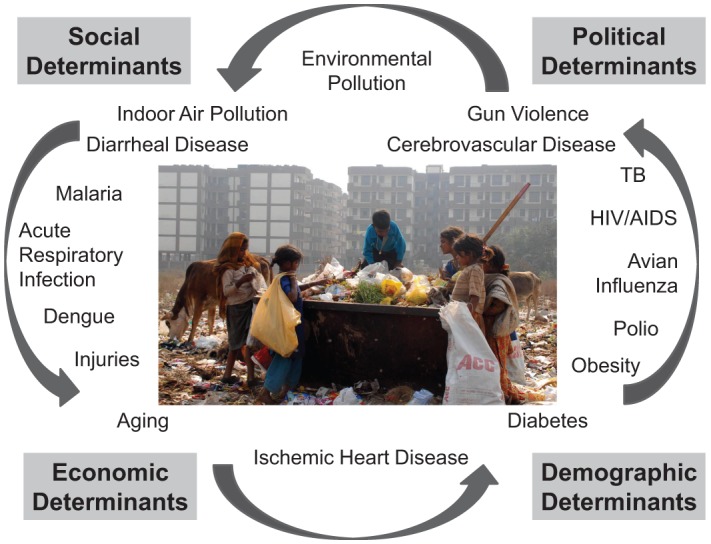
The Urban CruciblePhoto credit: ©2008 Pradeep Tewari, Courtesy of Photoshare